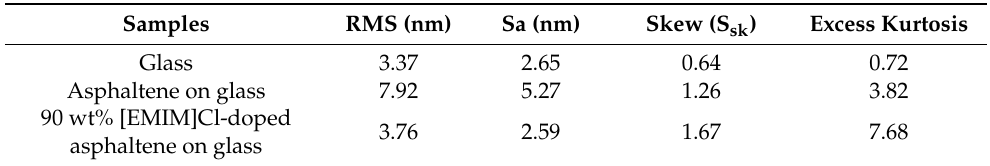
Table 2. AFM surface analysis of the uncoated glass, undoped, and 90 wt% [EMIM]Cl-doped asphaltene thin film on